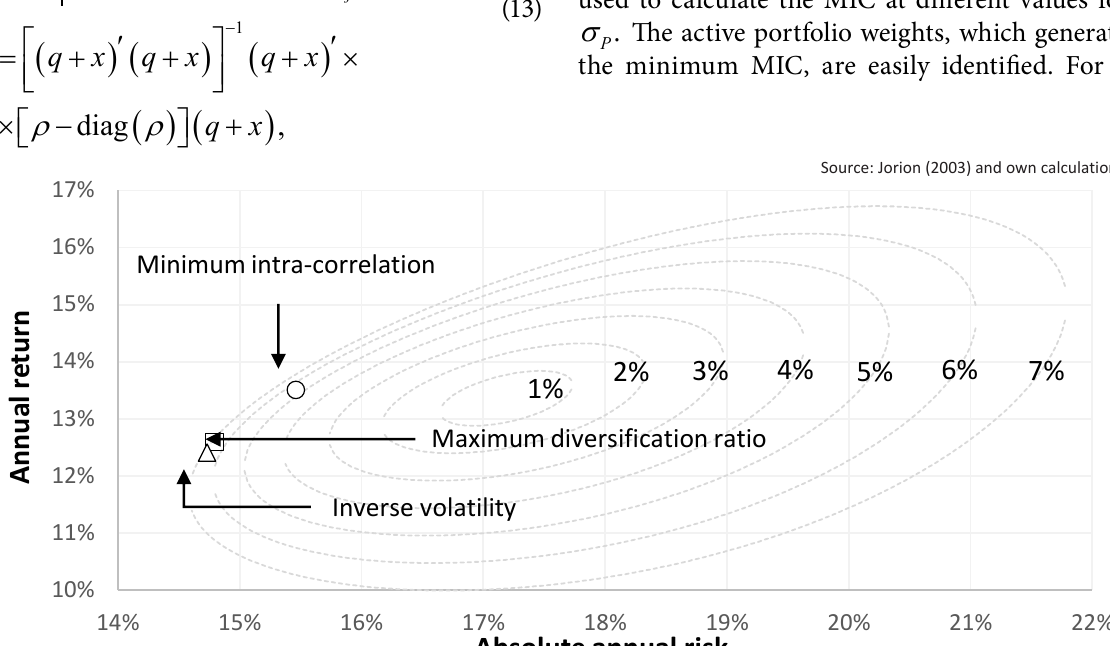
Source: Jorion (2003) and own